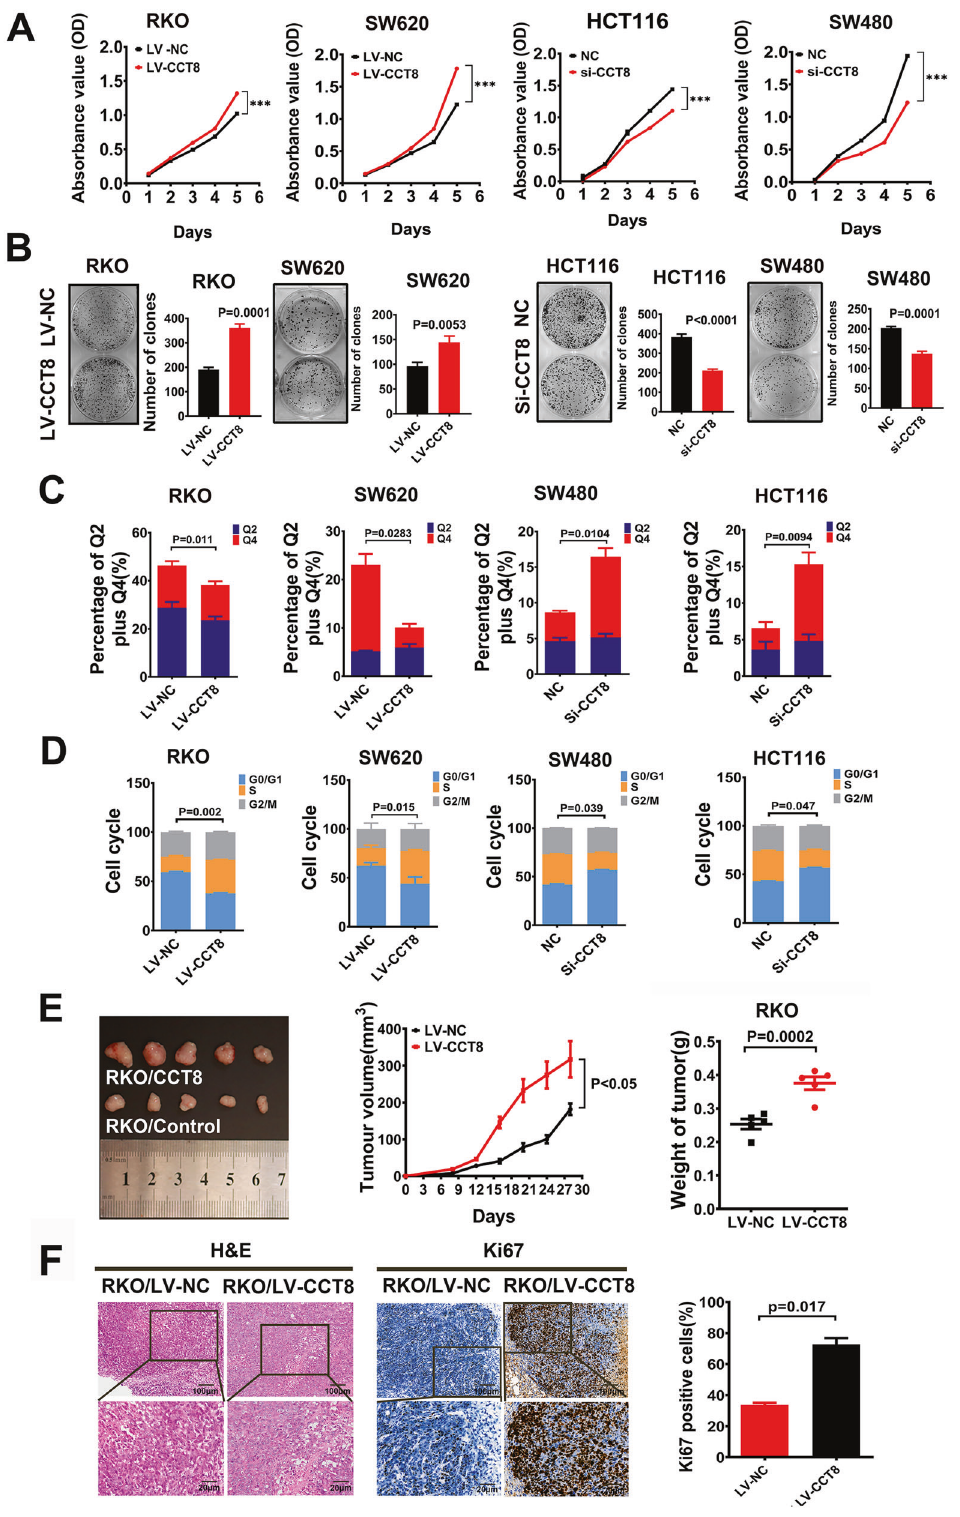
Fig. 3 CCT8 promoted the proliferation of CRC cells in vivo and in vitro. A The CCK8 assay was performed to study the effects of CCT8 on CRC cell proliferation in loss- and gain-of-function analysis. B Representative fi gures and data of colony formation assay in indicated cells. Bars of the right panel represented the number of formed cells. C Bars represent apoptosis in vitro after treatment of fl uorouracil for 12 h. D Bars represent the cell cycle analysis in CCT8 overexpressed and silenced CRC cell lines. E Resected xenograft tumors were injected with RKO/LV- CCT8 and RK0/LV-NC. The tumor growth curve over time and the fi nal tumor weight in the scatter plot graph. F Representative fi gures of HE staining of subcutaneous tumor were shown. Proliferative ability was measured by the Ki-67 proliferative labeling index. Bars of the right panel represent the Ki-67 index of subcutaneous